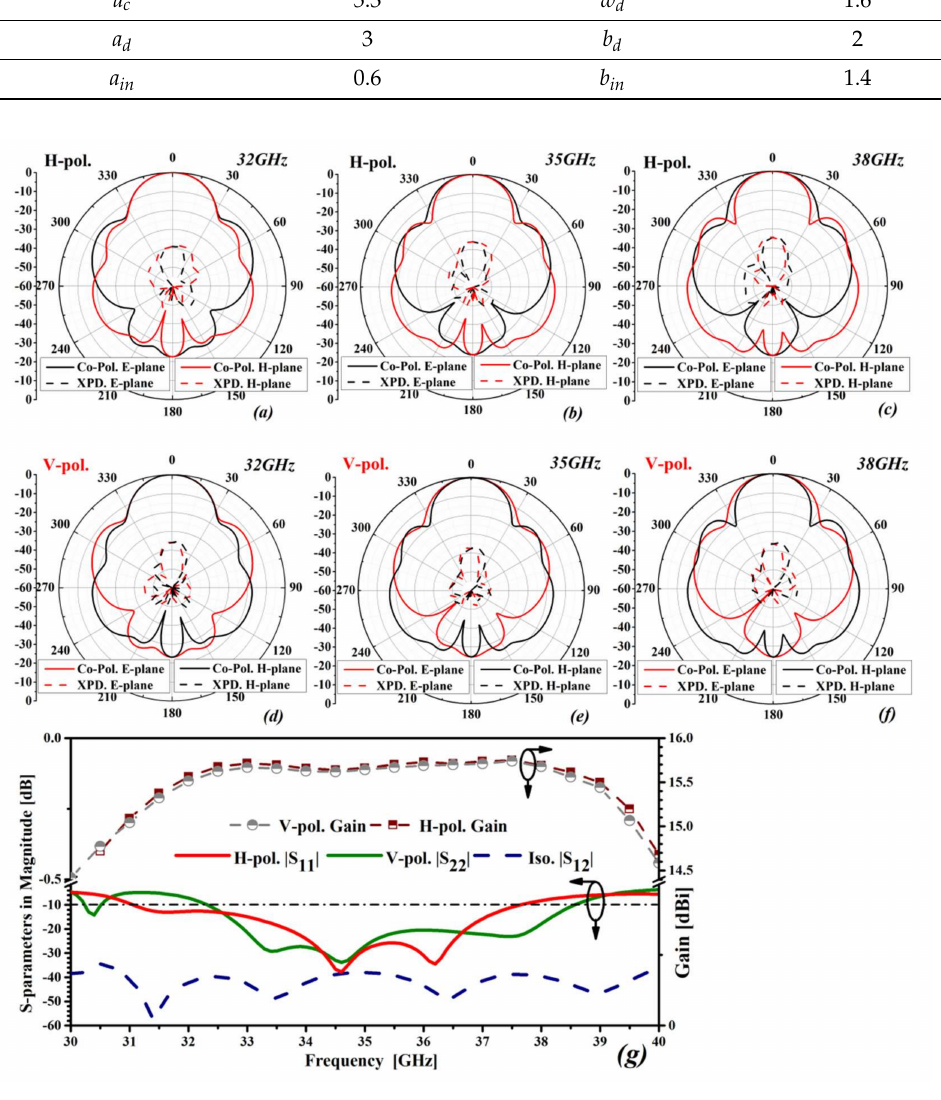
Figure 7. Simulated performances of the dual-polarization ME-dipole subarray: ( a – f ) radiation patterns; ( g ) S-parameters and